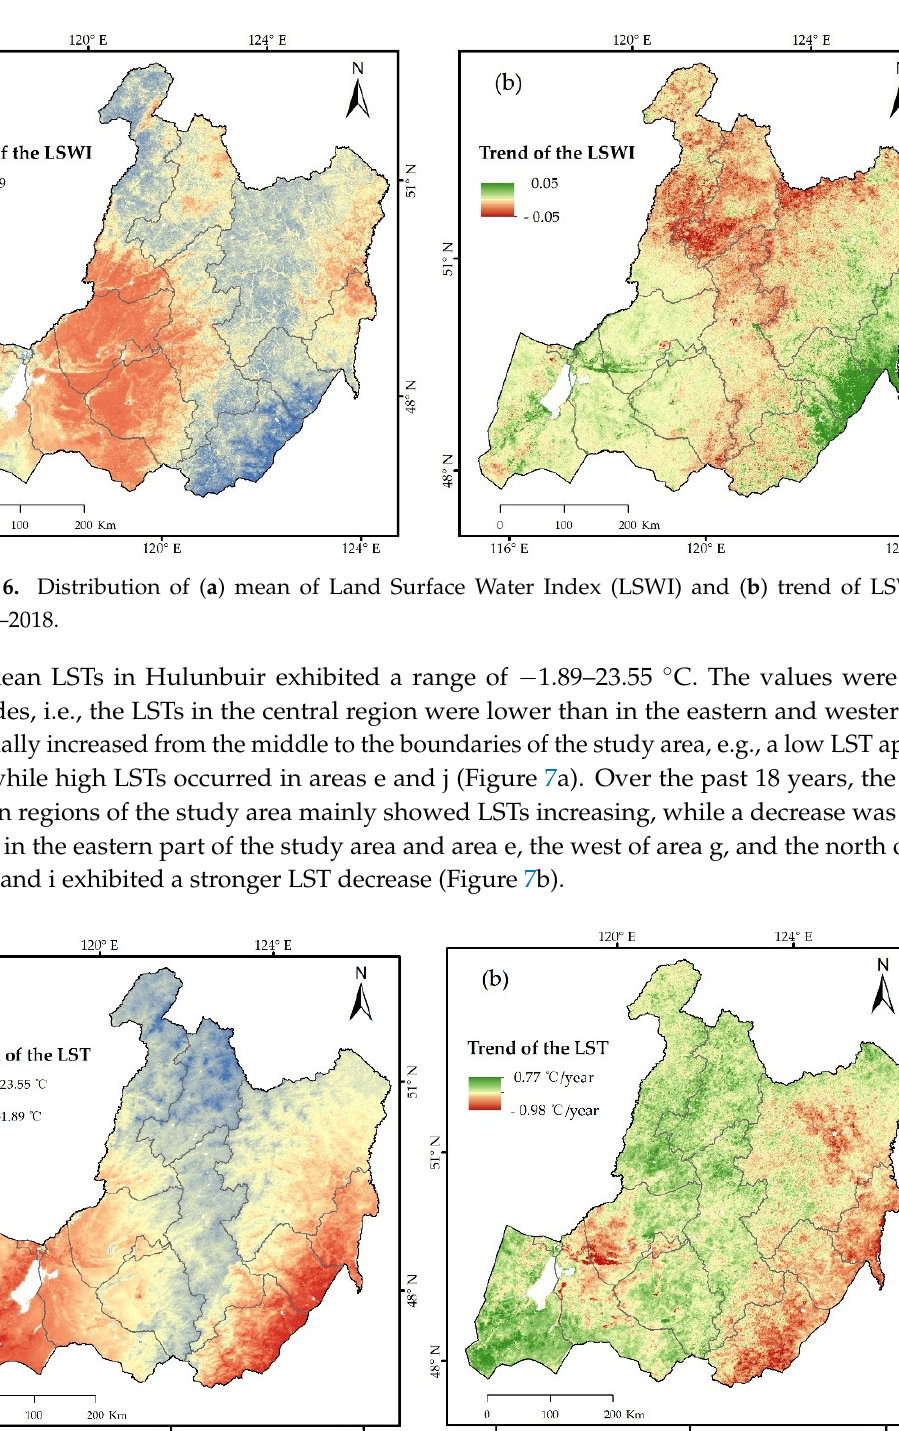
Figure 7. Distribution of ( a ) mean of land surface temperature (LST) and ( b ) trend of LST in 2001– 2018.